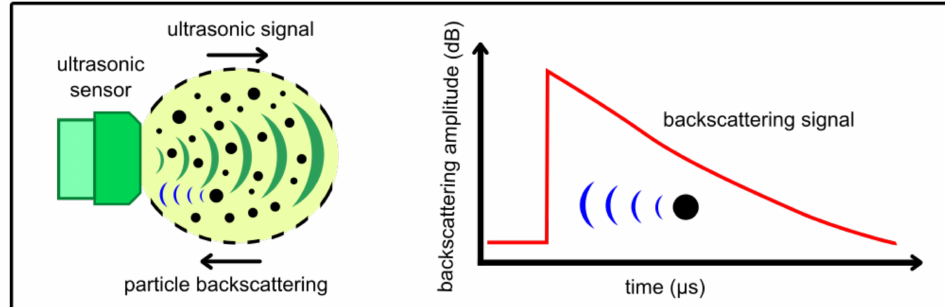
Figure 4. Ultrasonic backscattering. The sensor setup is shown on the left, with ultrasonic signal and particle backscattering. The backscattering signal with amplitude reflected from a particle population is shown on the